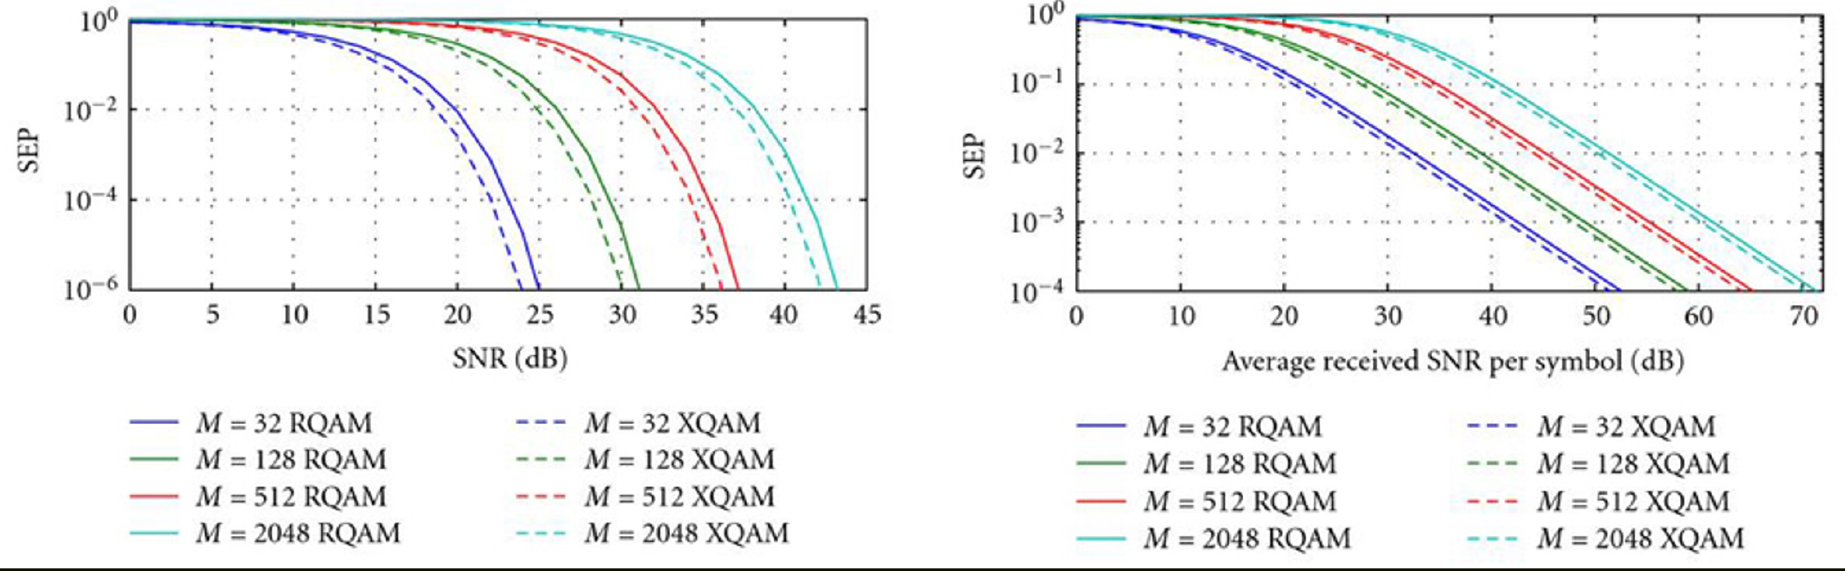
Figure 6 SEP comparison between rectangular QAM and cross-QAM. AWGN ChannelsRayleigh Channels